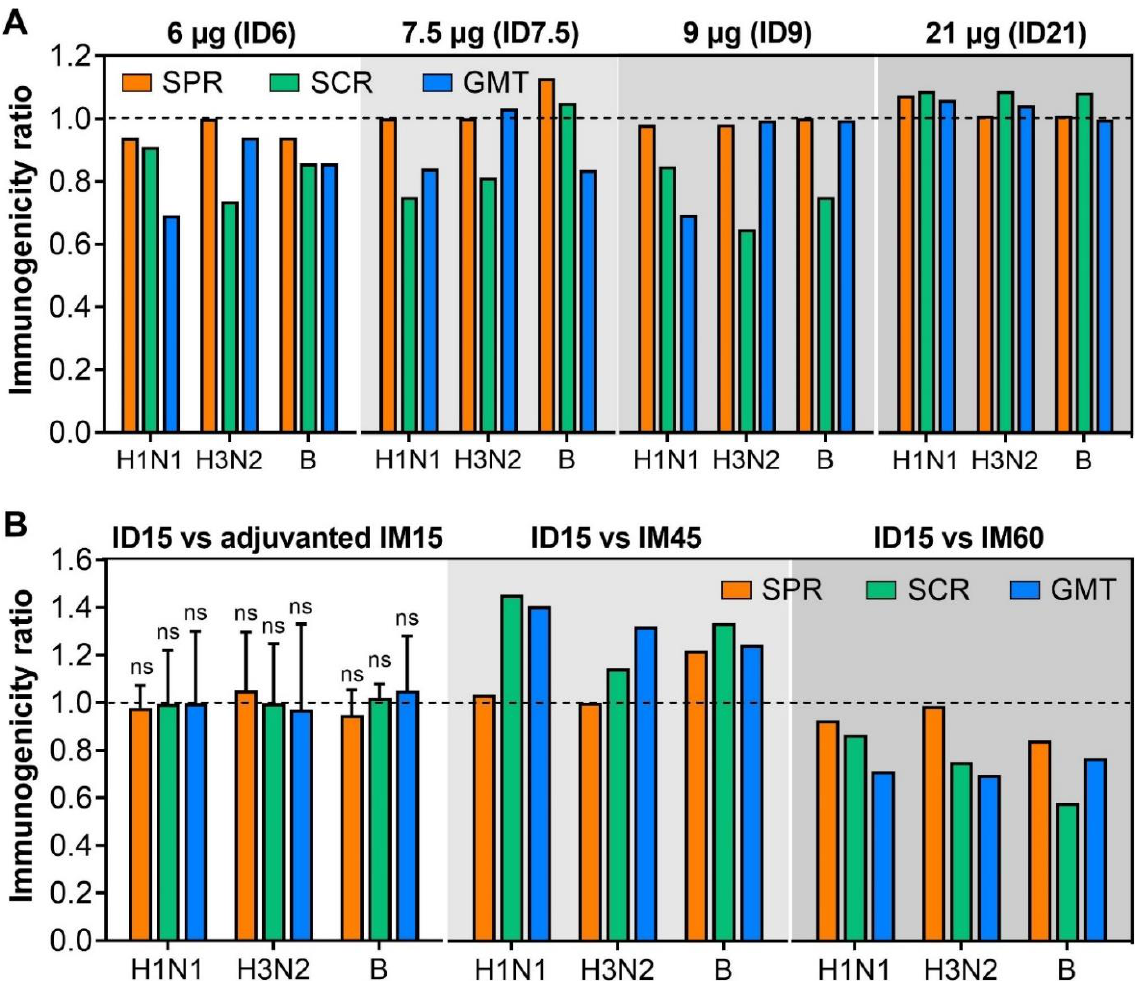
Figure 2. Comparison of the immunogenicity induced by varying amounts of hemagglutinin antigen in ID vaccines ( A ) and by standard-dose ID vaccines and MF59-adjuvanted IM15 and high-dose IM vaccines (B) in the elderly. ( A ) Comparison of immunogenicity induced by various dosages, including 6 µ g (ID6), 7.5 µ g (ID7.5), 9 µ g (ID7.5), 21 µ g (ID21) and standard dosage (15 µ g) of influenza vaccines injected intradermally. The ratios of SPR, SCR, and GMT were calculated by dividing the mean SPR, SCR, and GMT of ID vaccination of various dosages by those of standard-dose ID15. A ratio of <1 (dash line) implies a lower immunogenicity of varying dosages of ID vaccination than ID15. ( B ) Comparison of immunogenicity of standard-dose ID15 and MF59-adjuvanted IM15, high dose (45 µ g or IM45, 60 µ g or IM60) of IM vaccines. The ratios of SPR, SCR, and GMT were calculated by dividing the mean SPR, SCR, and GMT of ID15 by those of adjuvanted IM15, IM45, and IM60. A ratio of >1 (dash line) implies a higher immunogenicity of ID15 over adjuvanted ID15, IM45, and IM60. One sample t -test was used to examine the significant difference in the immunogenicity ratios against hypothesized ratio of 1. “ns” = non-significant. Due to limited studies comparing the immunogenicity of ID15 and ID vaccines at varying amounts of hemagglutinin antigen, ID15